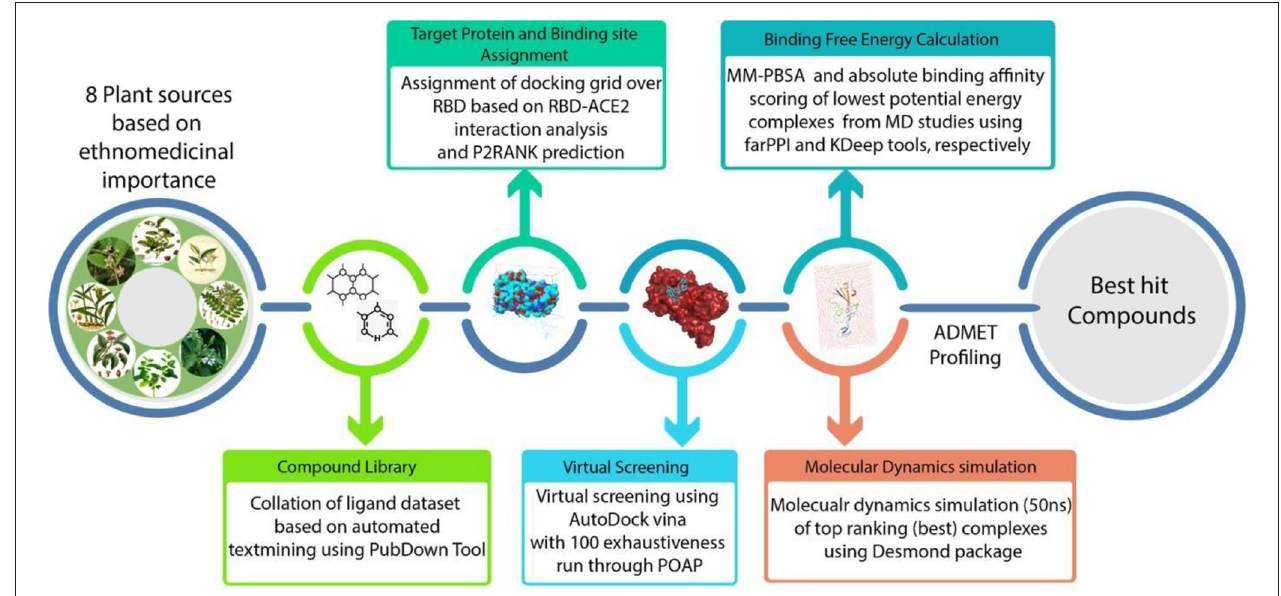
FIGURE 4 | A schematic representation of methodologies implemented in this study.